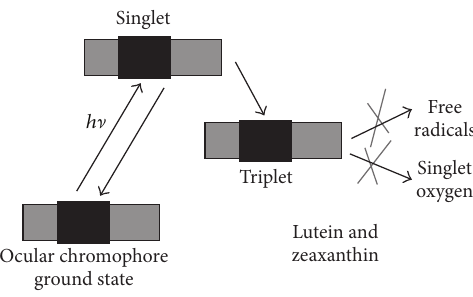
Figure 4: Photochemical mechanism of protection.